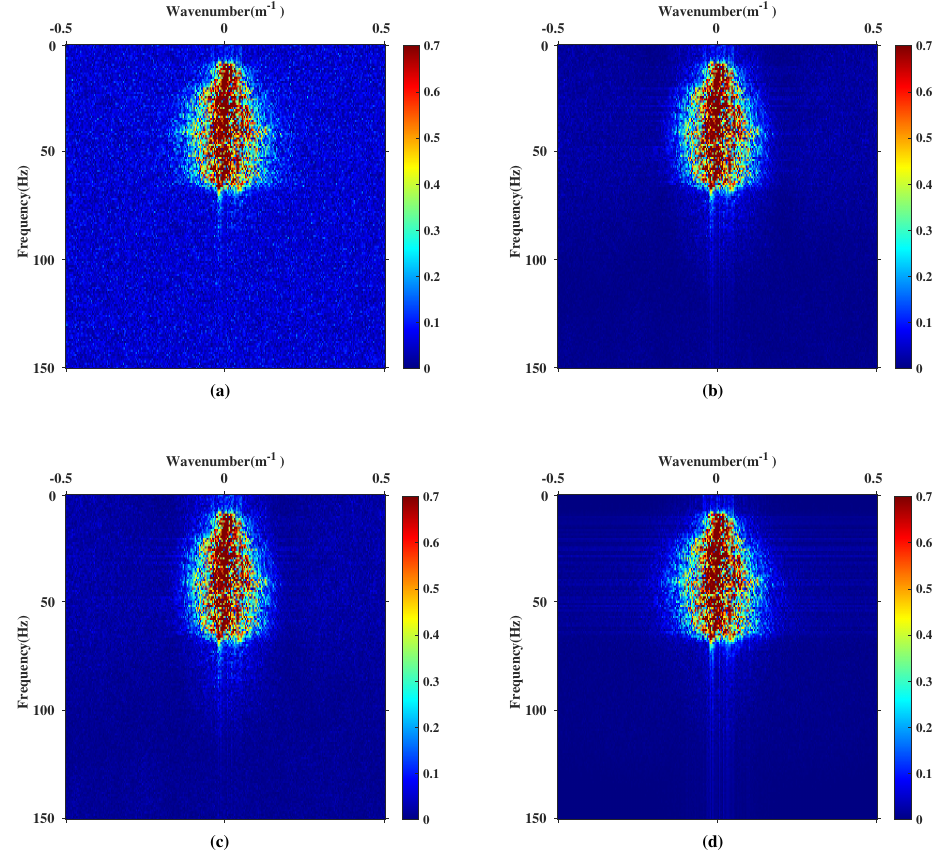
Figure 9. The comparison of three methods of the FK spectrum in real seismic data. ( a ) The FK spectrum of field desert post-stack seismic data. ( b ) The FK spectrum of the denoised result using the APF method. ( c ) The FK spectrum of the denoised result using DnCNN. ( d ) The FK spectrum of the denoised result using